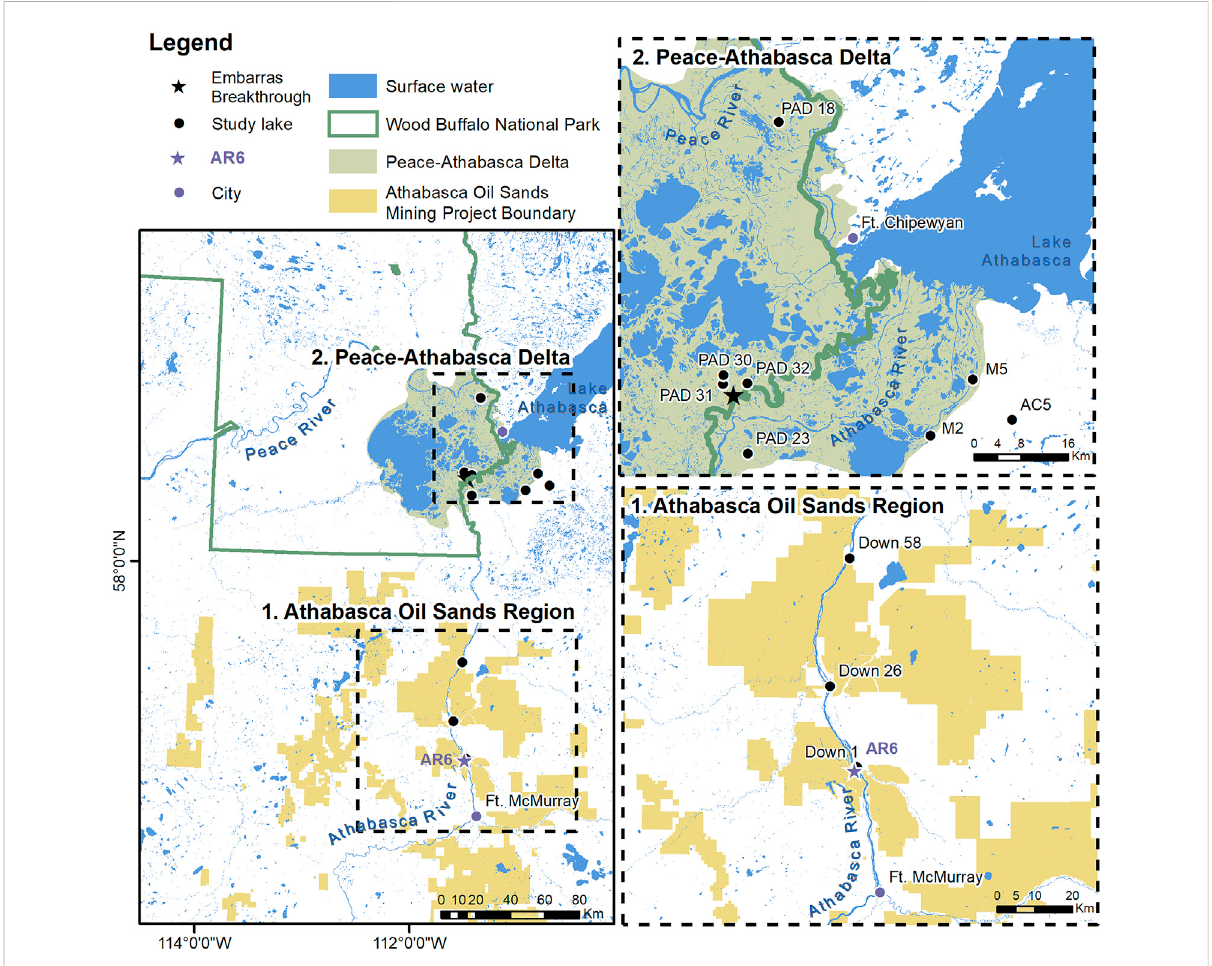
FIGURE 1 Map showing sampling sites for lakes (black circles) in the AOSR and PAD region, located in northeastern Alberta (Canada). The Wood Buffalo NationalParkboundaryisdenotedbythedarkgreenline,thePADisshadedingreenandtheAthabascaOilSandsminingfootprintincludingholdings for future developments in 2021 is shaded in brown. Fort McMurray and Fort Chipewyan are denoted by purple circles and AR6, a central location in